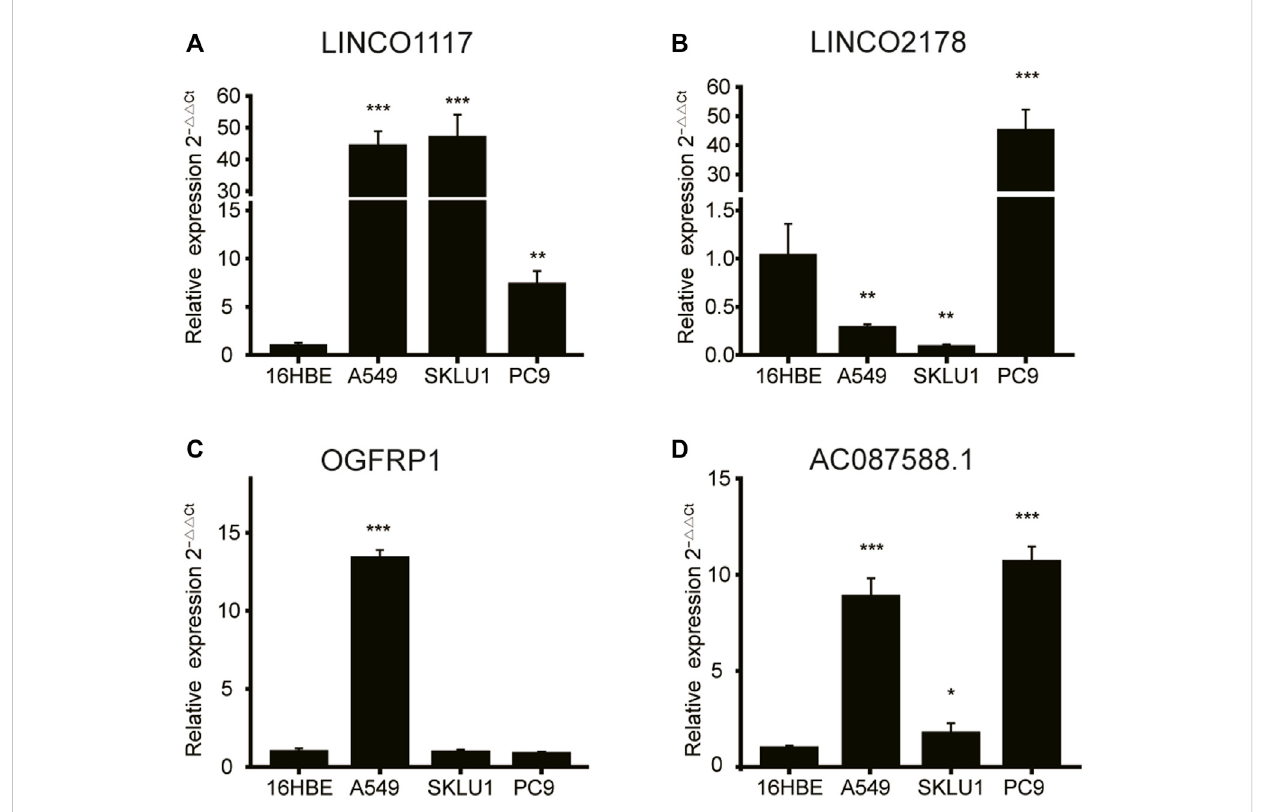
FIGURE 9 The qRT-PCR results of 4 lncRNAs ’ expression in lung adenocarcinoma and normal bronchial epithelial cell lines. (A) LINC01117, (B) LINC02178, (C) OGFRP1, (D) AC087588.1. lncRNA: Long non-coding RNA. * p < 0.05, ** p < 0.01, and *** p < 0.001.